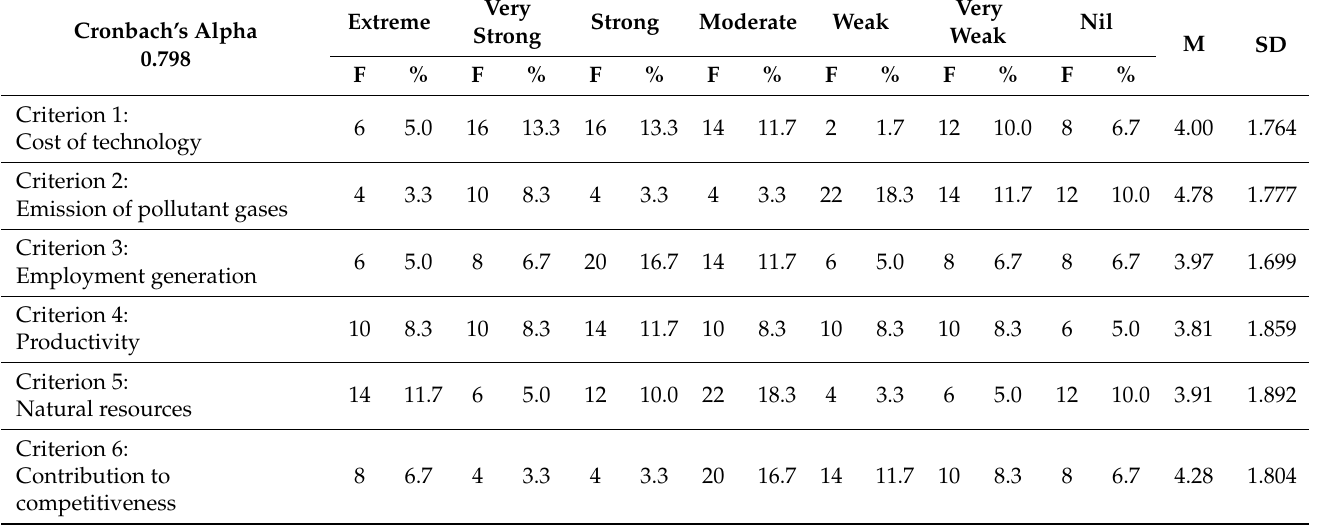
Table 17. Algae attractiveness